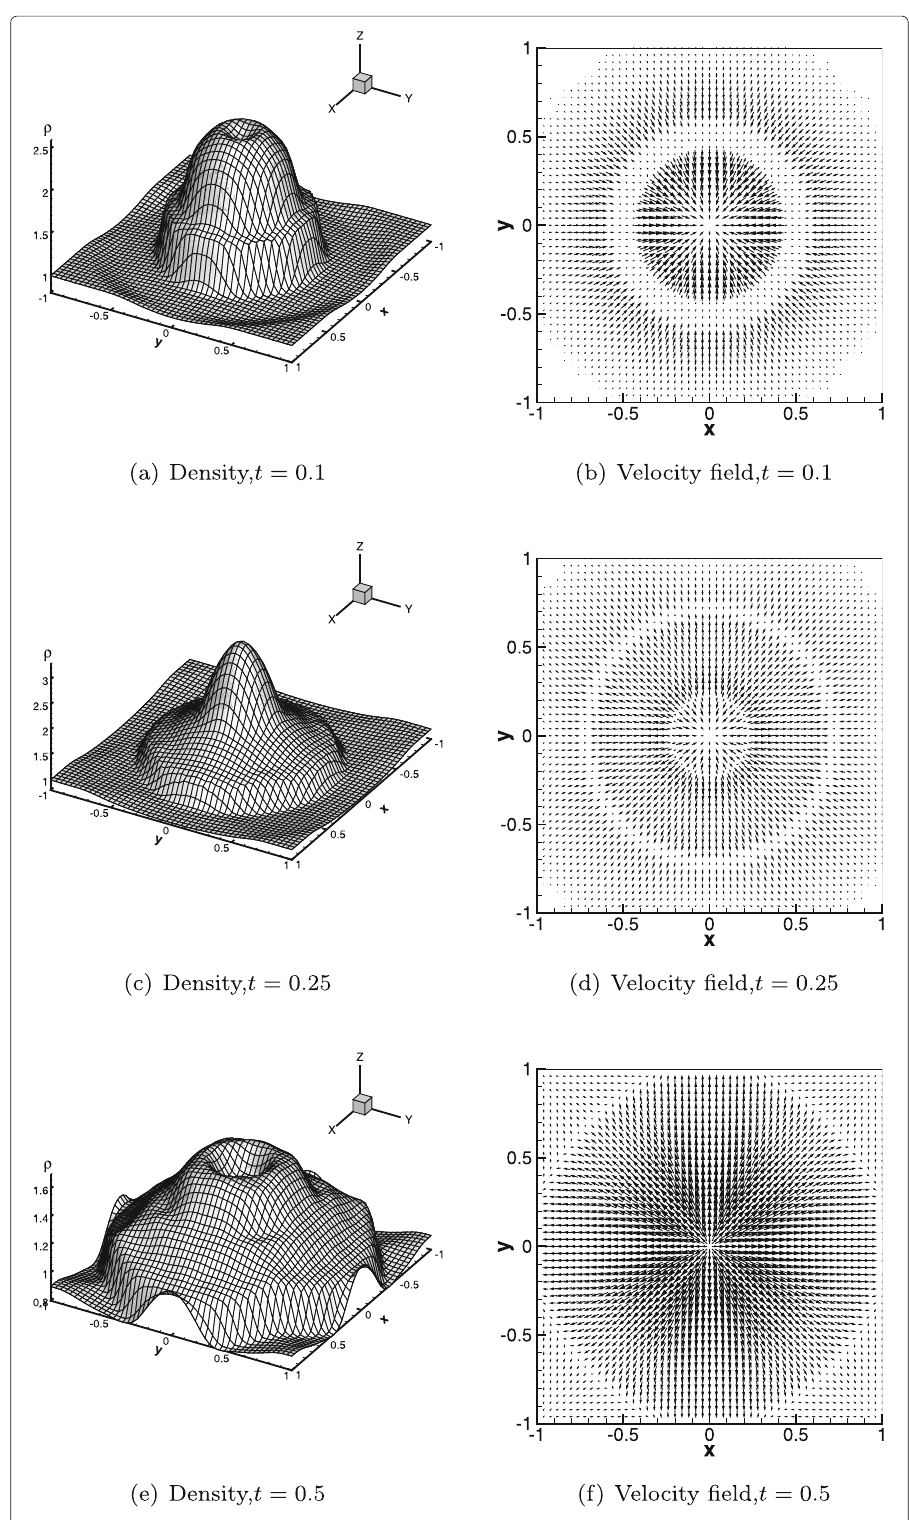
Fig. 4 Example 6. Density (left) and velocity field (right) calculated by the GSA IMEX-ARS3 WCNS on a mesh 50 × 50 at the Mach number ε = 1. a Density, t = 0.1. b Velocity field, t = 0.1. c Density, t = 0.25. d Velocity field, t = 0.25. e Density, t = 0.5. f Velocity field, t =